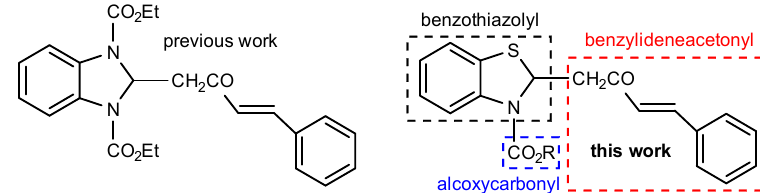
Figure 1. Benzylidenacetonyl substituted heterocyclic compounds.